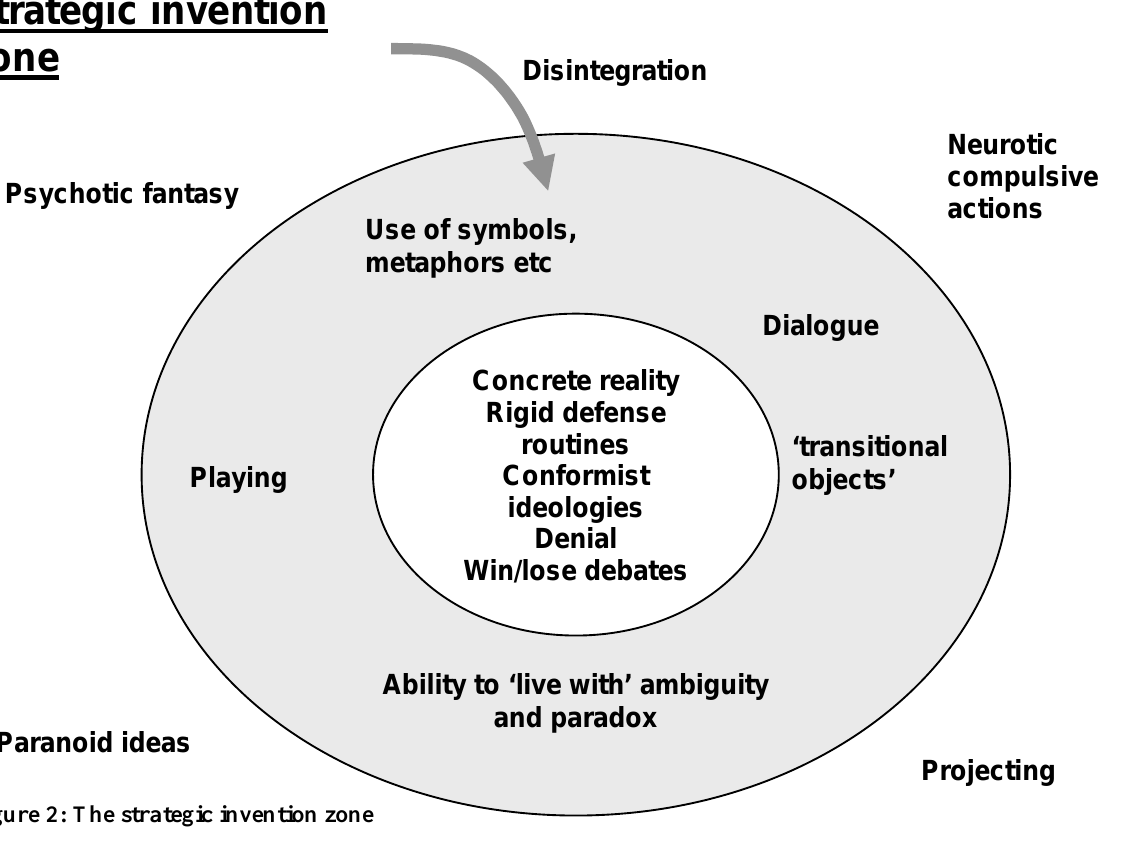
Figure 2: The strategic invention zone